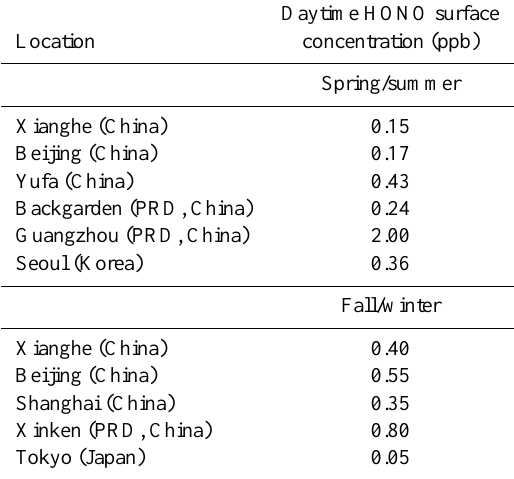
Table 2. Compilation of existing daytime ( ± 3h around local noon) HONO surface concentration measurements performed in or in the vicinity of big cities in East Asia. Beijing and Xianghe values cor- respond to the present study while other data are taken from Li et al. (2012; see also references therein). PRD is for Pearl River Delta region.